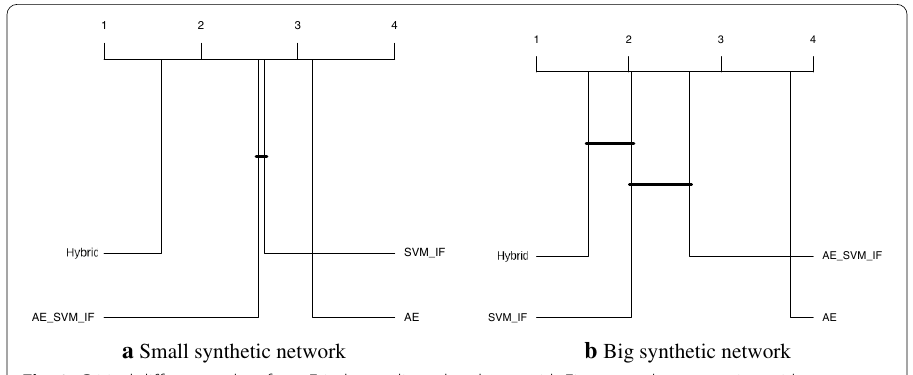
Fig. 9 Critical difference plots from Friedman aligned rank test with Finner p value correction with significance level α = 0.05 comparing Hybrid, AE_SVM_IF, SVM_IF and AE algorithms on the small and big synthetic networks. Algorithms which are not connected with the horizontal dark line are significantly different than each other. Lower rank indicates an overall better